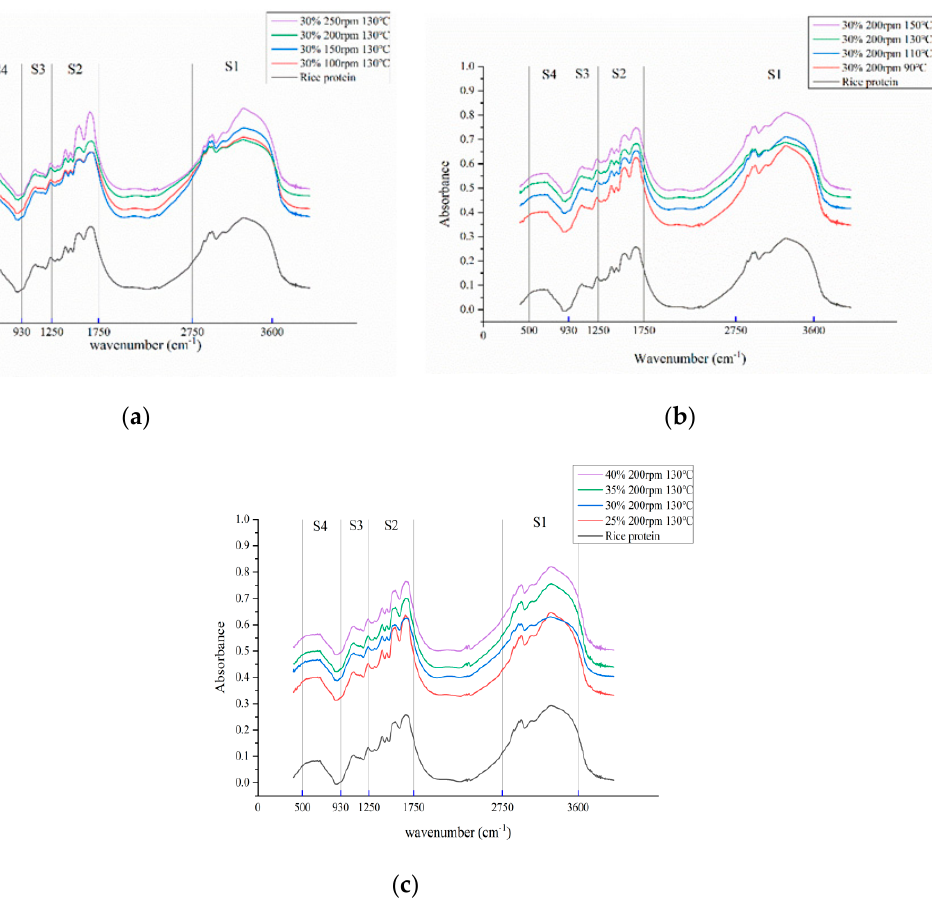
Figure 2. FITR spectrum of TRP with different extrusion parameters ( a ) FITR spectrum of TRP at different screw speeds; ( b ) FITR spectrum of TRP at different extrusion temperatures; ( c ) FITR spectrum of TRP at different moisture contents. Table 6. Protein secondary structure of TRP under different extrusion parameters.